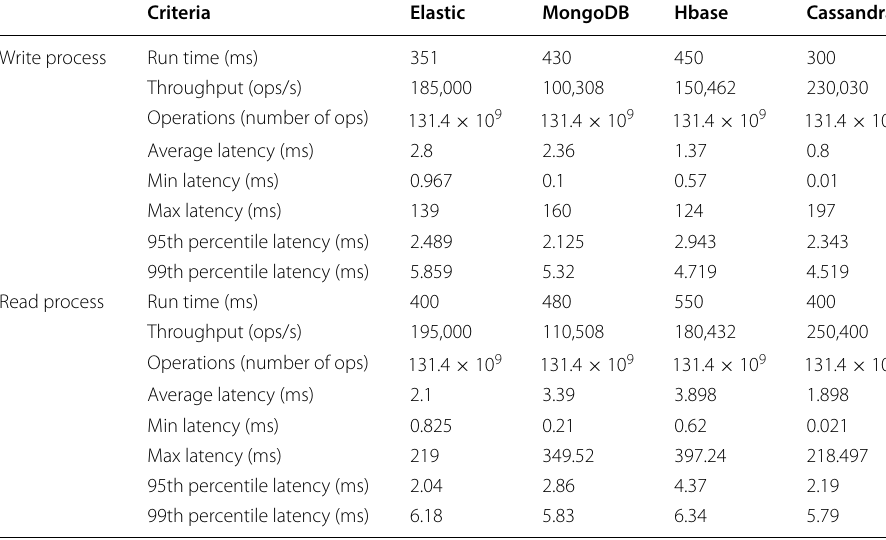
Table 2 The summarized performance criteria